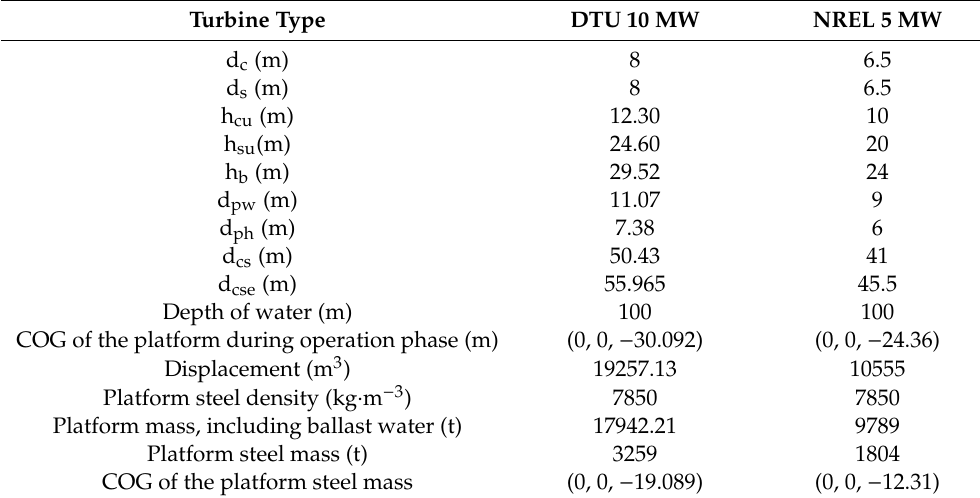
Table 3. Properties of the platform of the